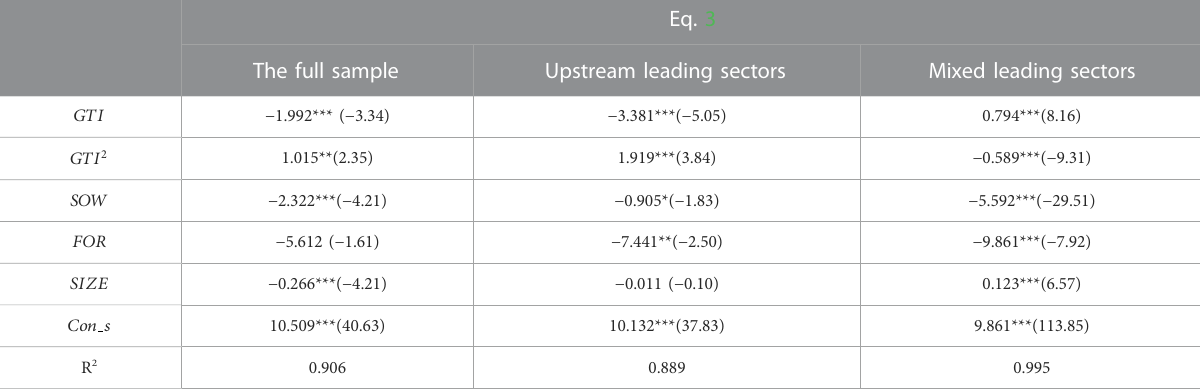
TABLE 4 Regression results of green technology innovation and GVC upgrading in subsectors of equipment manufacturing